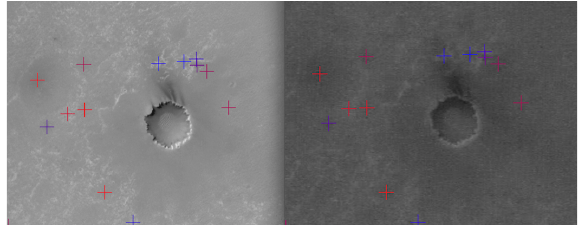
Figure 3 Example of detected TPs (showing from red to blue with increasing similarity value 0-1) for MER-B CTX ORI(left) and HRSC ORI (right) at Victoria Crater